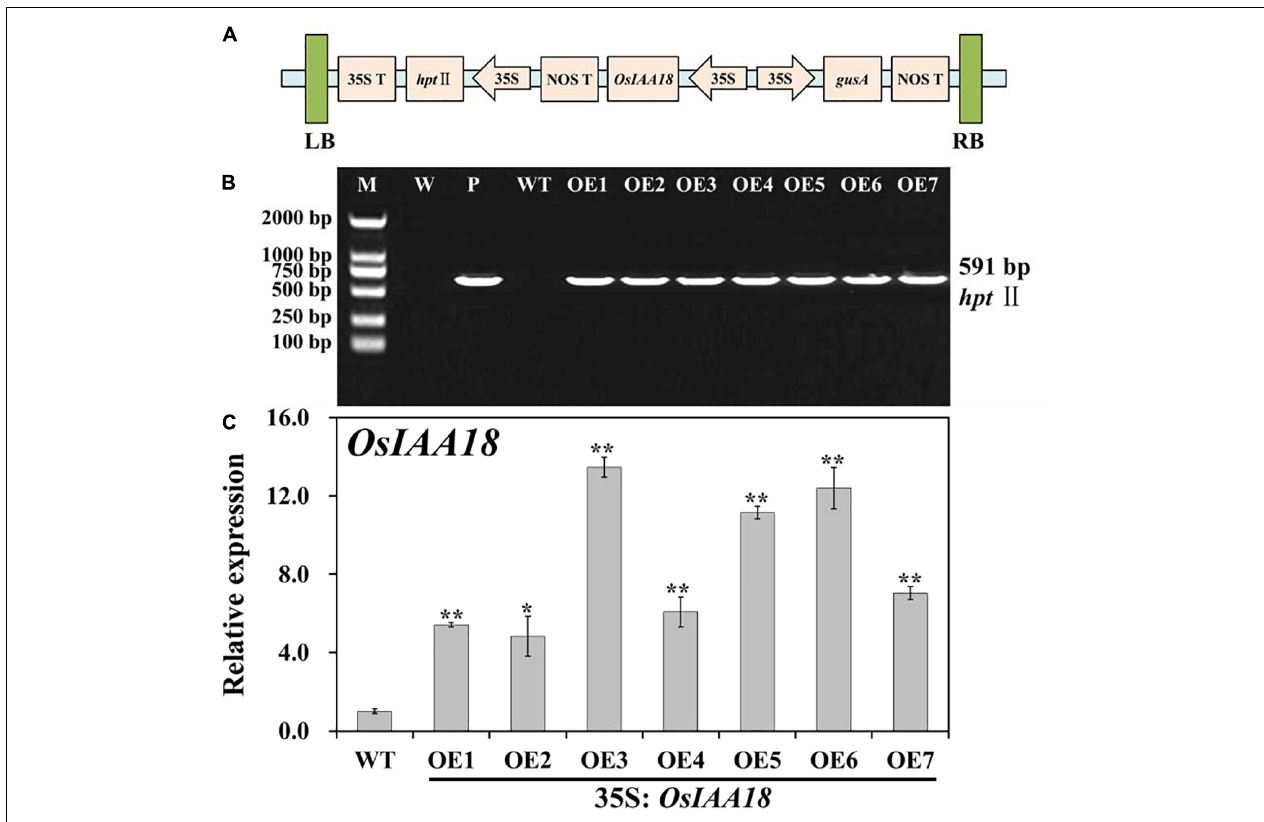
FIGURE 1 | Molecular analyses of the OsIAA18 -overexpressing rice plants. (A) Schematic diagram of the T-DNA region of binary plasmid pCAMBIA1301- OsIAA18 . LB left border; RB right border; hpt II hygromycin phosphotransferase II gene; OsIAA18 rice auxin/indoleacetic acid (Aux/IAA) transcription factor gene; gusA β -glucuronidase gene; 35S cauliflower mosaic virus (CaMV) 35S promoter; 35S T CaMV 35S terminator; NOS T nopaline synthase terminator. (B) PCR analysis of transgenic rice plants. Lane M, DL2000 DNA marker; Lane W, water as negative control; Lane P, plasmid pCAMBIA1301- OsIAA18 as positive control; Lane WT, wild type; Lanes OE1, OE2, OE3, OE4, OE5, OE6, and OE7, overexpressing OsIAA18 rice plants. (C) Expression level of OsIAA18 in the overexpressing OsIAA18 rice plants. The rice OsActin gene was used as an internal control. The results are expressed as relative values based on WT as reference sample set to 1.0. Data are presented as means ± SE ( n = 3). The values for * and ** indicate a significant difference from that of WT at P < 0.05 and < 0.01, respectively, by Student’s t -test.